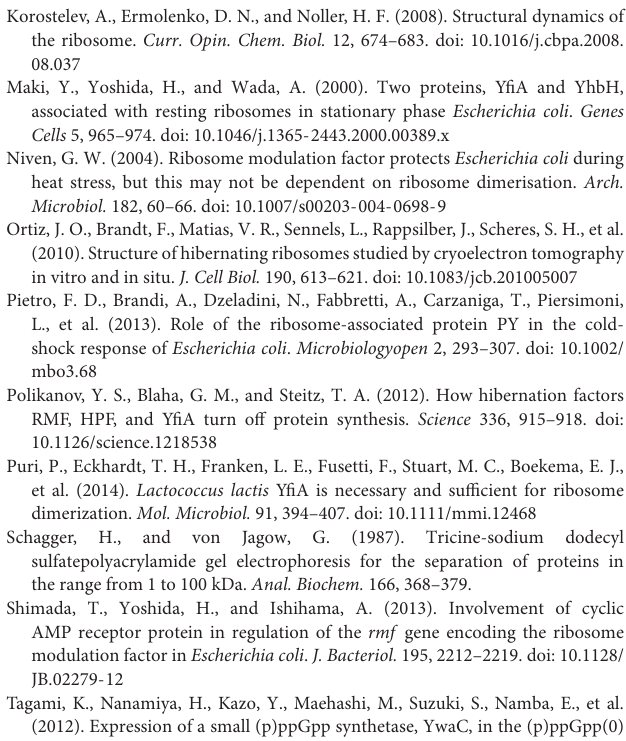
Supplementary Figure 2 | Optimization of conditions for ribosomal dimerization after the expression of rmf and hpf genes from plasmids. YB1005 cells harboring